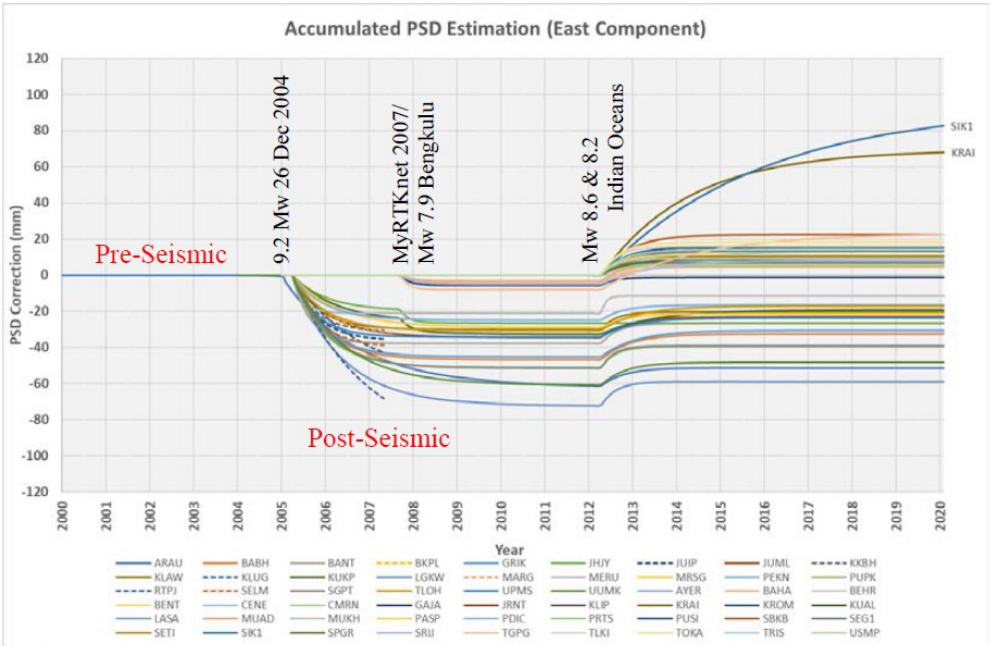
Fig. 11. The nonlinear PSD parametric model trajectories (computed at 30-day intervals) of the Malaysian CORS stations in the E-W direction from epoch 2000.0 (with a big impact from the Mw 9.2 Sumatra-Andaman megathrust earthquake since the end of 2004) to 2020.0. Dashed lines indicate decommissioned CORS